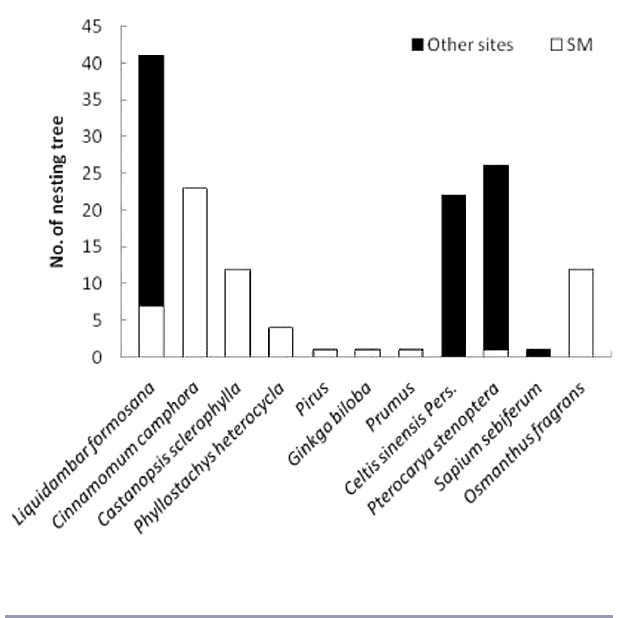
Fig. 2 . Nesting trees in Shimen (SM). White represents the number of nesting trees in SM, black represents the number in other sites. The cumulative of white and black is the number of trees chosen for nesting.